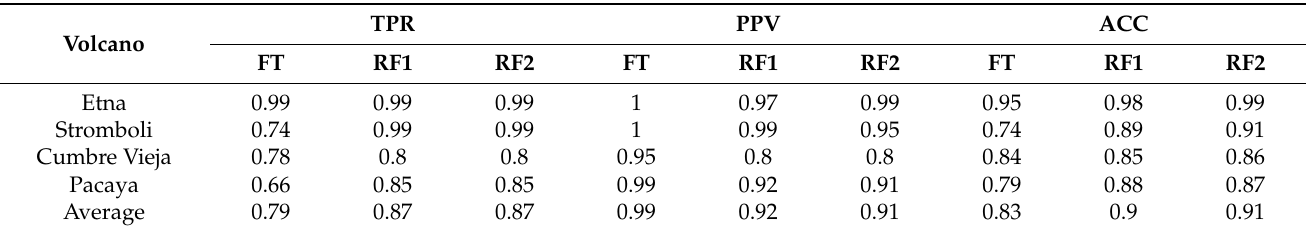
Table 4. Performance indices, i.e., TPR, PPV, and ACC, for the test set for each volcano and average scores using the fixed threshold algorithm (FT), RF1 model, with NIR, SWIR bands, and NHI indices, the RF2 model with VISIBLE, NIR, and SWIR bands. The goodness of the trained models is evaluated by using the performance indexes previously